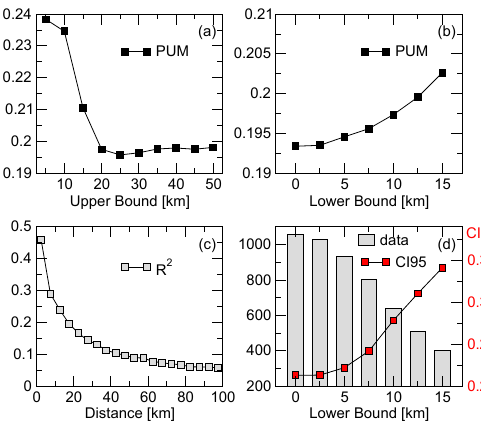
Figure 3. Variation of the RL50 PUM given by Eq. (1), as a func- tion of (a) the upper and (b) the lower bound to the pooling radius. (c) Common variance between series of annual maxima versus dis- tance of sites, computed at a 5km step, starting from a minimum distance of 2.5km. (d) Variation of both the mean number of data in the pooled samples and the mean amplitude of the CI95 as a func- tion of the lower bound to the pooling radius.